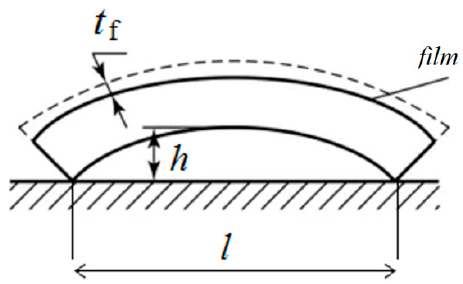
Figure 3. Schematic of residual bending stress.